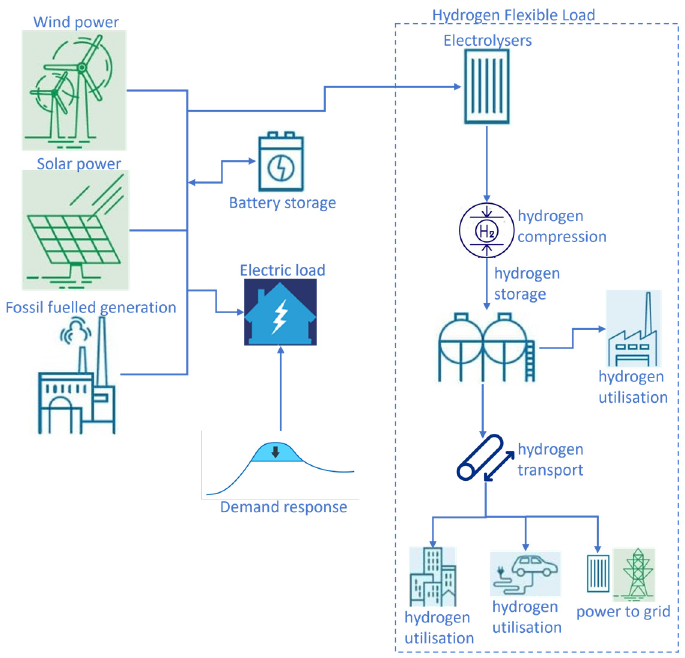
Figure 7. Hydrogen production is integrated into the electrical grid as a flexible load.